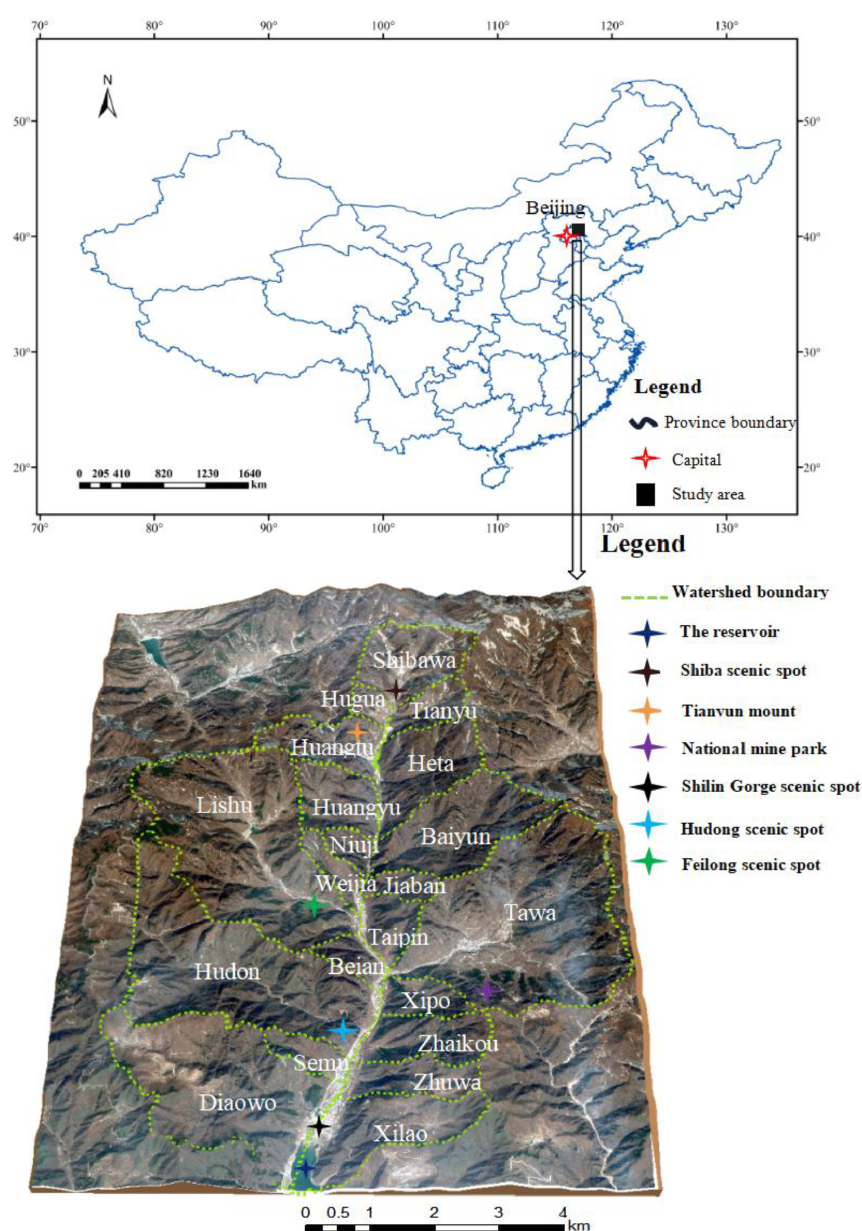
Figure 2. Geographical positions of the Huangsongyu scenic region and the investigated 21 debris flow